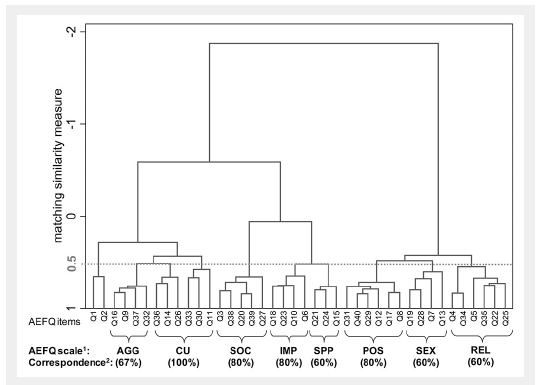
Cluster analysis dendrogram for the 40 items of the Alcohol Effects Questionnaire (AEFQ) – Ward’s linkage analysis. 1. AEFQ scales: Global Positive (POS), Social and Physical Pleasure (SPP), Sexual Enhancement (SEX), Power and Aggression (AGG), Social Expressiveness (SOC), Relaxation and Tension Reduction (REL), Cognitive and Physical